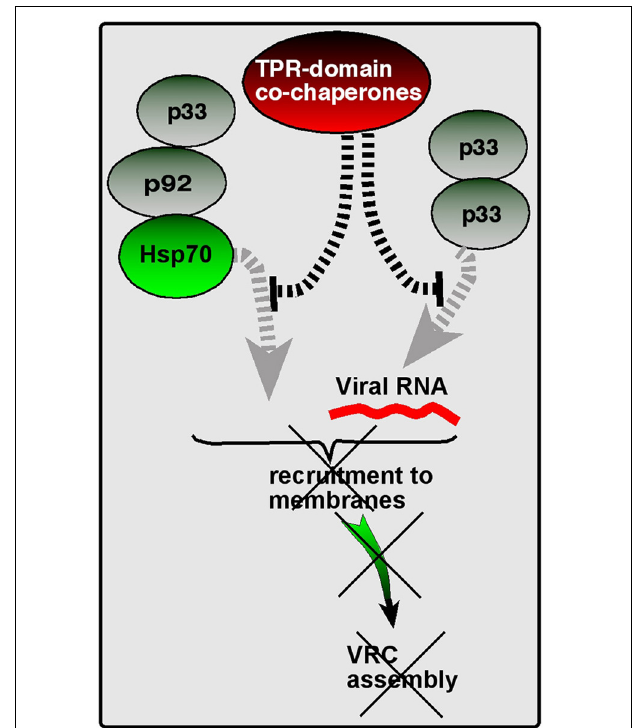
FIGURE 5 | A model of the “guardian of Hsp70” function of TPR-containing co-chaperones. The ATP-dependent Hsp70 molecular chaperone is usurped by TBSV to facilitate recruitment of viral components to the subcellular (peroxisomal) membranes and also to promote VRC assembly. However, TPR-containing co-chaperones, such as the yeast Cyp40-like Cpr7p, Ttc4 oncogene-like Cns1p, and the Hop/Sti1 co-chaperones, might protect the Hsp70 chaperones from falling easy “prey” to TBSV by interacting with viral components. These events lead to the inhibition of viral processes, as shown, explaining how these co-chaperones work as